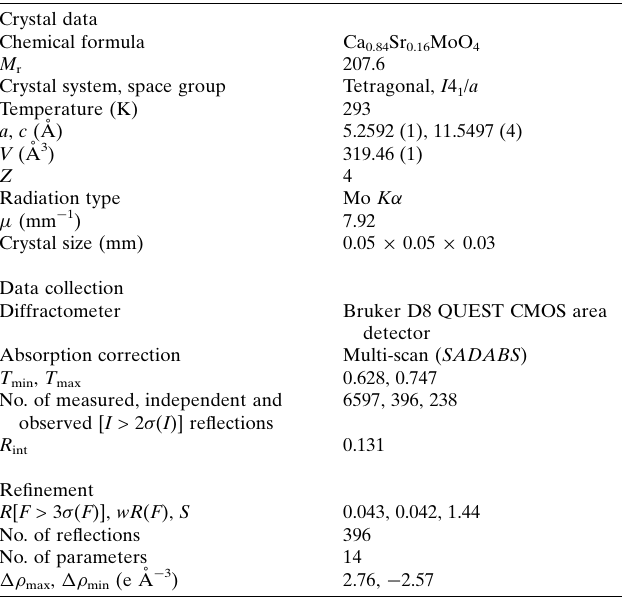
Table 2 Experimental details. Crystal data Chemical